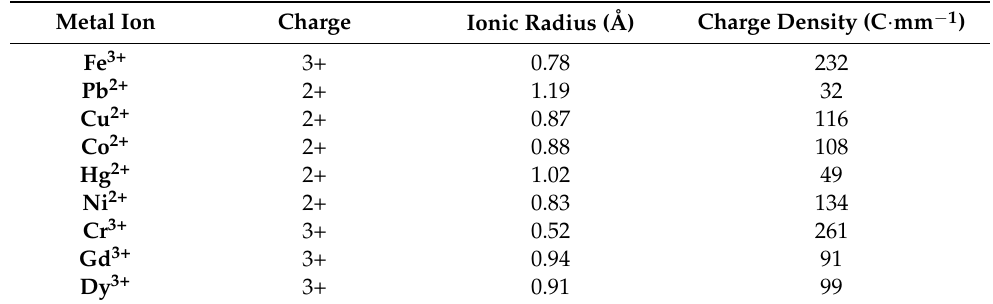
Table 2. Charge, ionic radii and charge densities of tested metal cations. Values obtained from